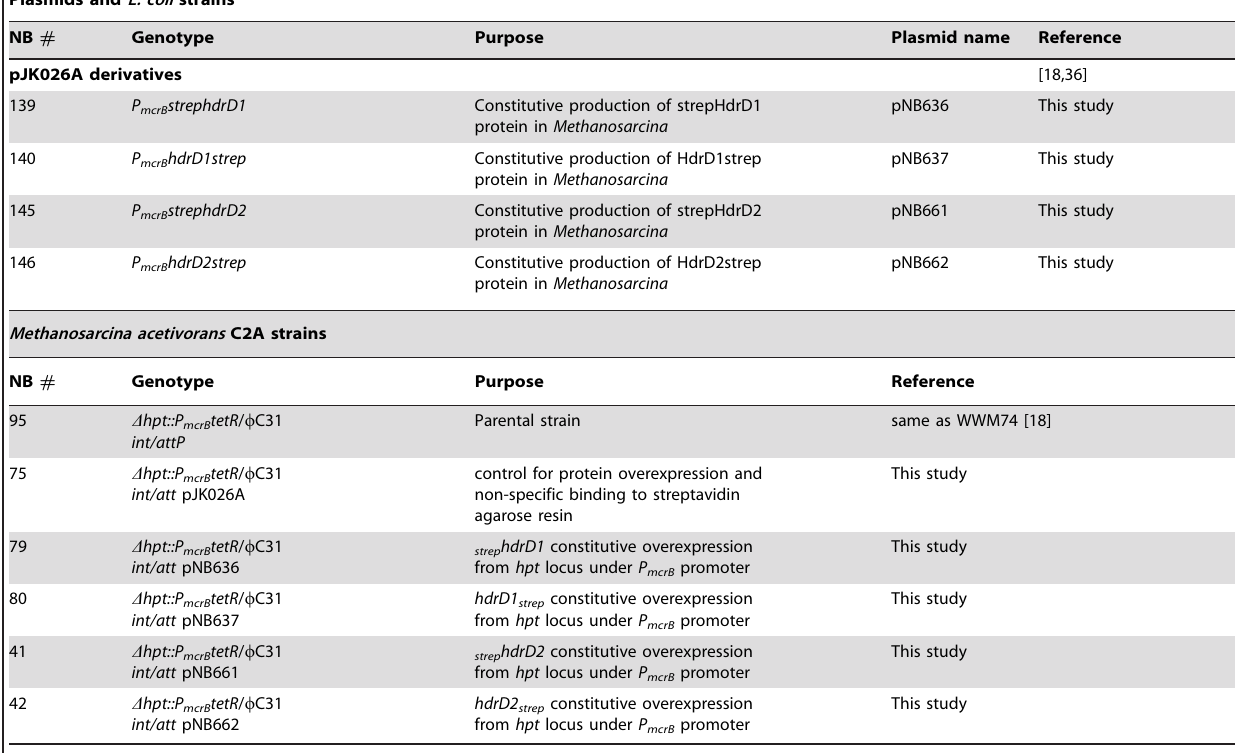
Table 1. Plasmids and strains used in this study.